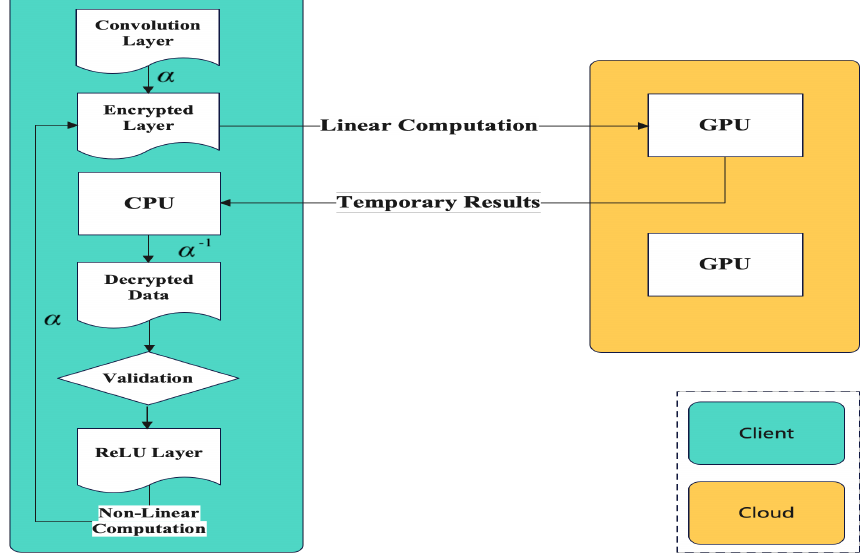
Figure 3. Details about implement of the protection, including encryption, decryption, and